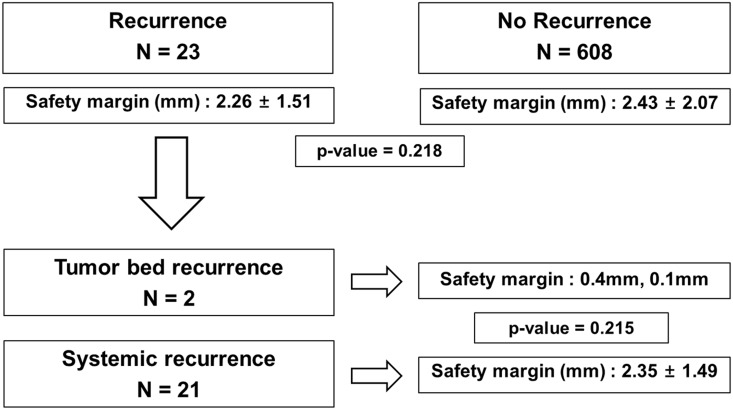
Comparison of the peritumoral surgical margin width according to cancer recurrence after a partial nephrectomy in 702 patients with clinical T1a renal cell carcinomas.